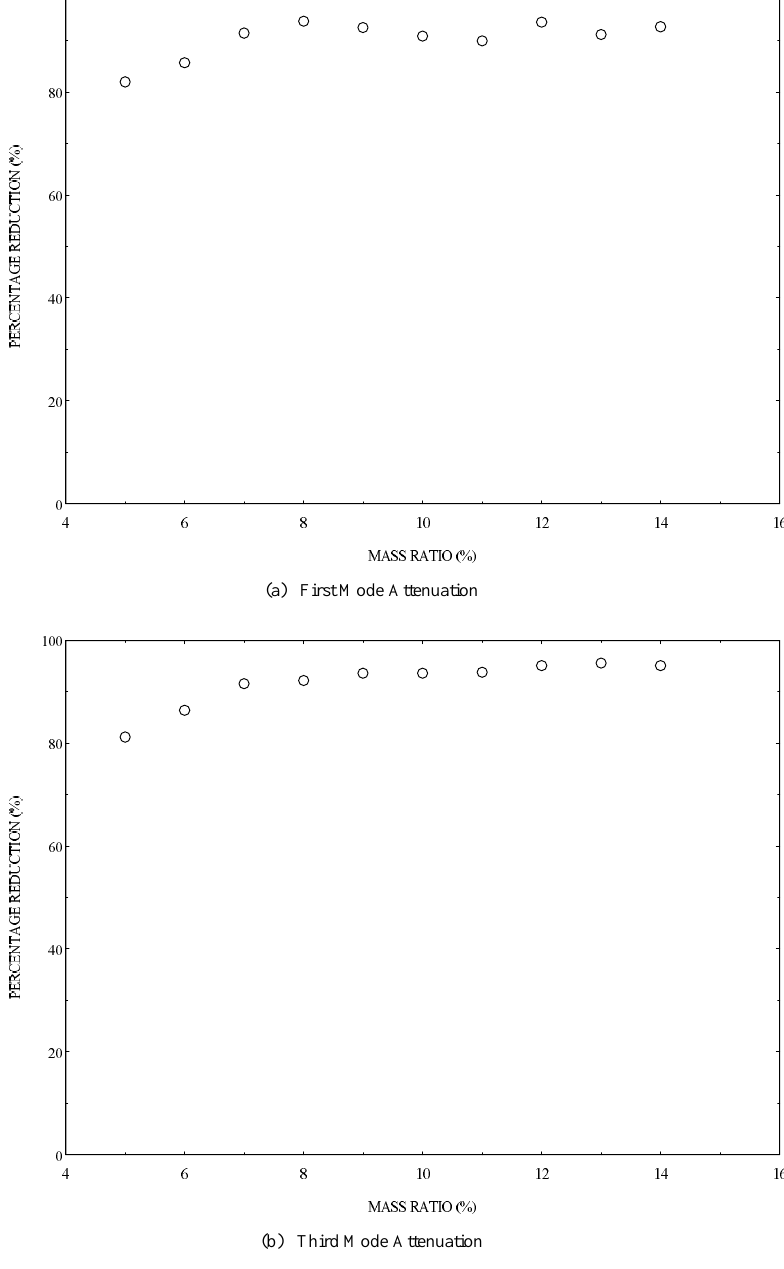
Fig. 5. Variation of vibration reduction with mass